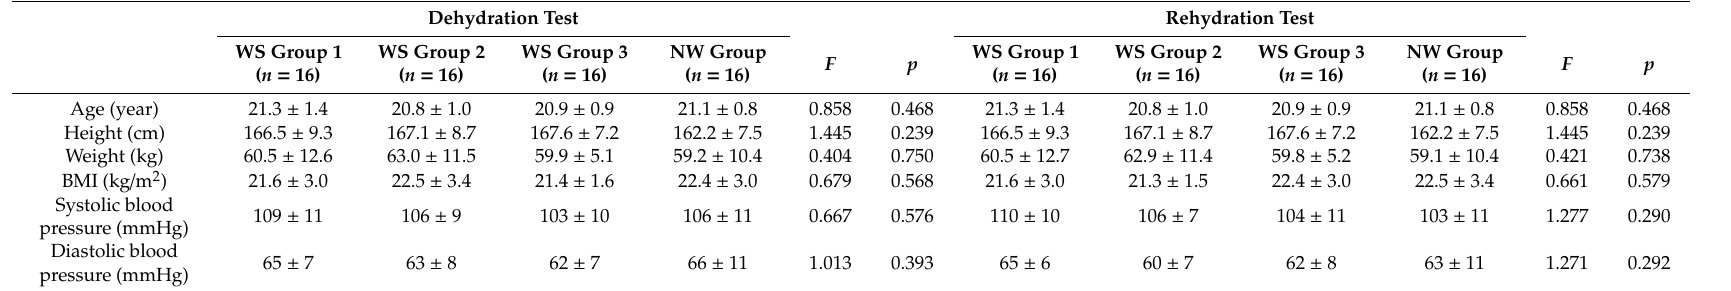
Table 1. Characteristics of the